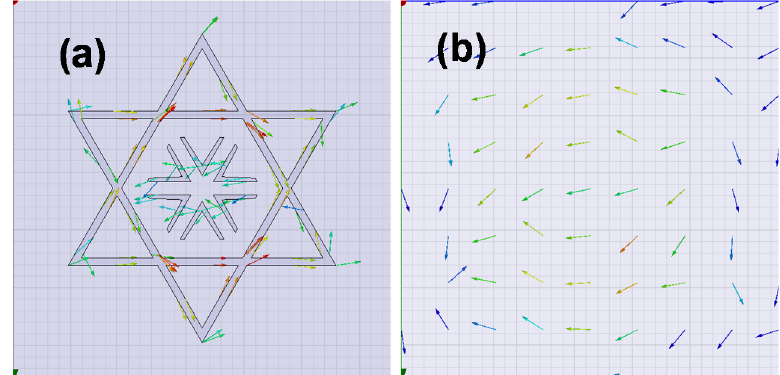
Figure 12. Currents on the metallization sheets: ( a ) top sheet and ( b ) bottom sheet.